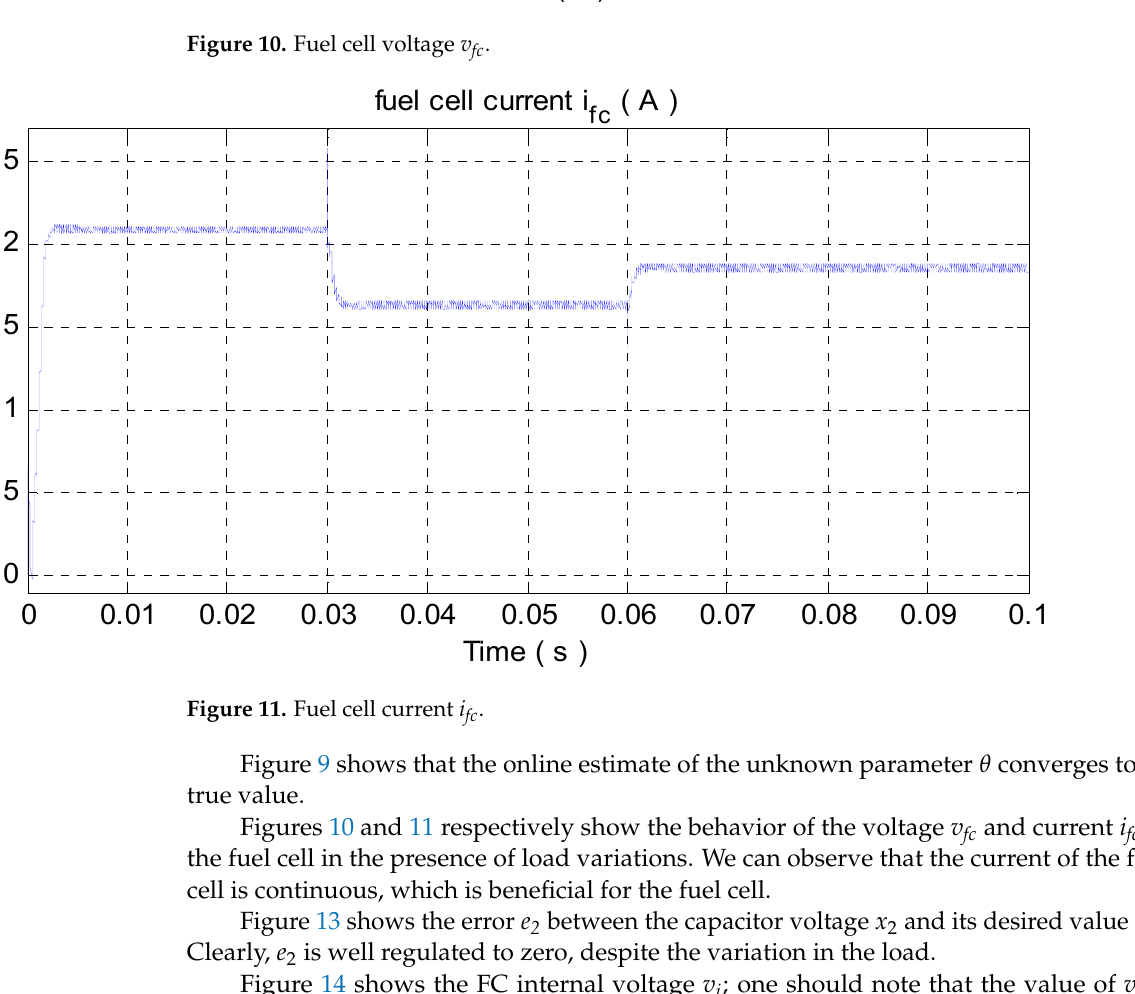
Figure 10. Fuel cell voltage v fc .